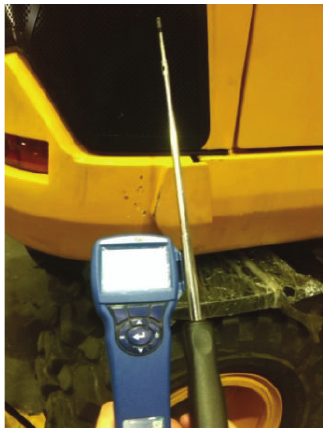
Figure 9: Experimental measurement.